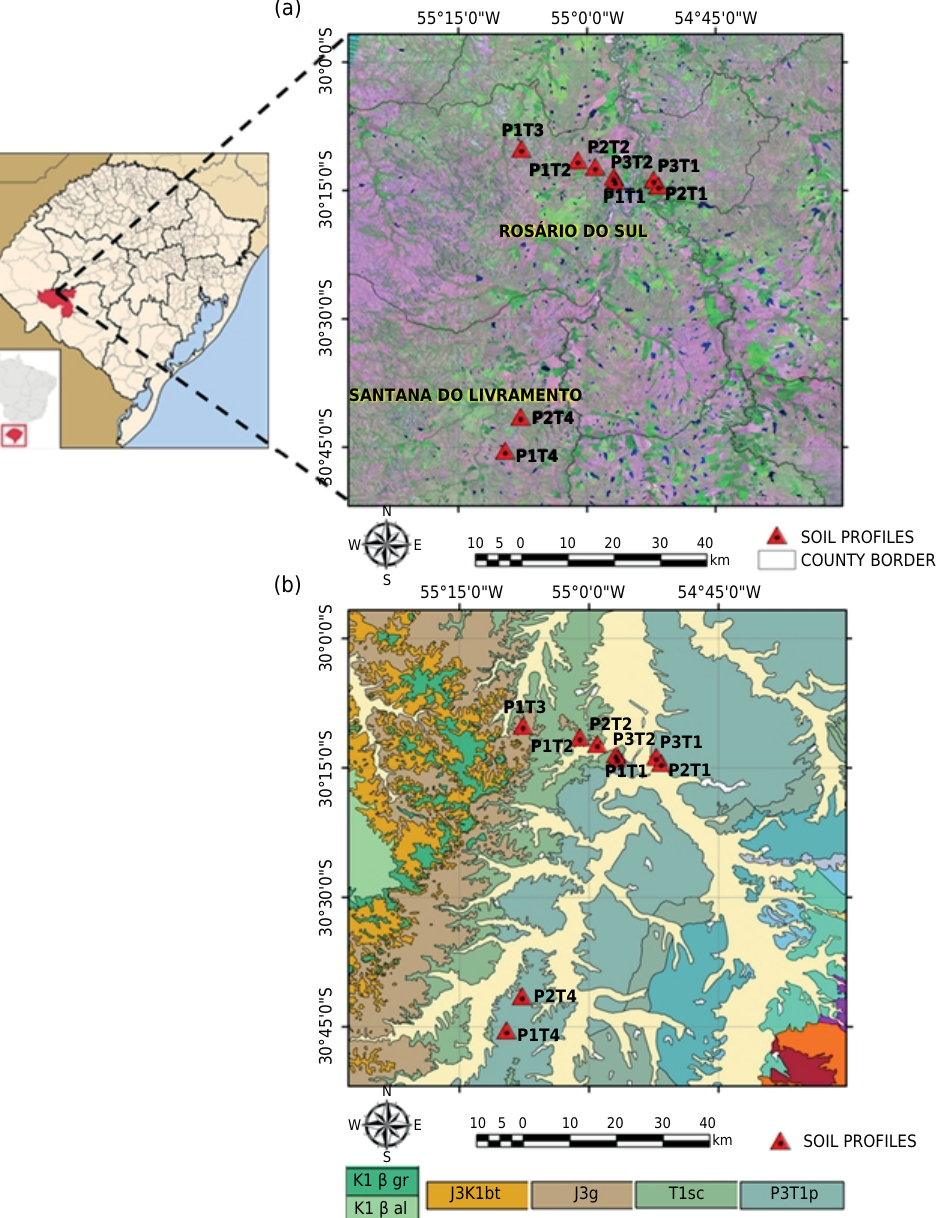
Figure 1. Image chart with the geographic location of the study area and soil profiles - Municipality of Rosário do Sul and Santana do Livramento/RS (Landsat Image 5 Thematic Mapper - Composition 5R4G3B / Datum SAD69 - Indicated Scale) (a); Simplified geological map of part of the southwest region of the state of Rio Grande do Sul (b). Main Formations - P3T1p: Pirambóia Formation; T1sc: Sanga-do-Cabral Formation; J3g: Guará Formation; J3K1bt: Botucatu Formation; K1β: Serra Geral Formation (scale